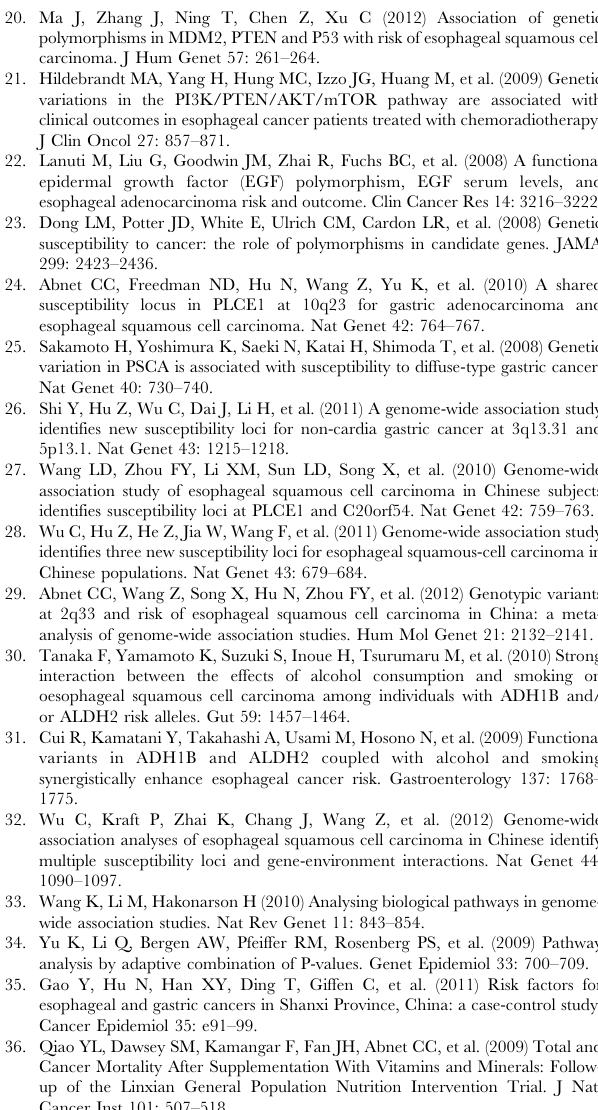
Table S1 The associations between all EGFR pathway genes and risk of esophageal squamous cell carcinoma and gastric adenocarcinoma. Table S2 The NCBI dbSNP identifiers, located genes, and chromosomes of SNPs included in the study. Table S3 Characteristics of the study